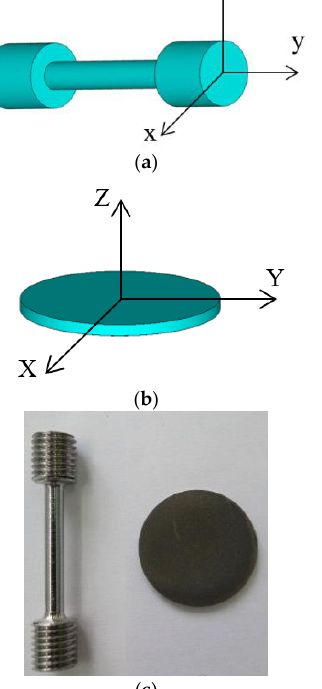
Figure 2. SLM specimen image: ( a )—tensile test specimens, ( b )—hydrogen permeability test specimens, ( c )—photos of ( a ) and ( b ) specimens.